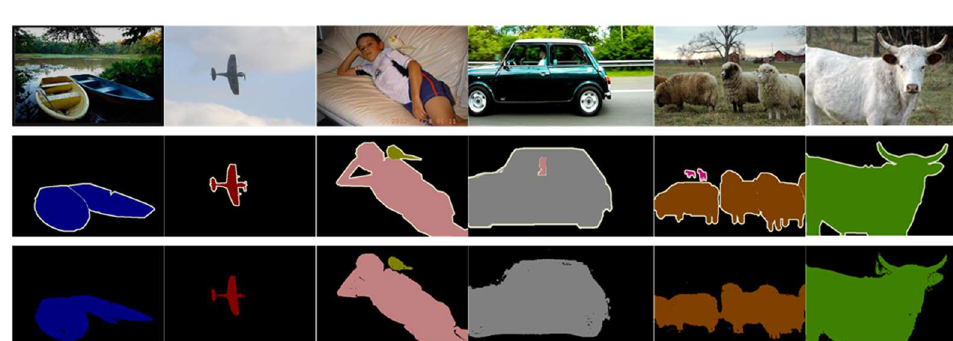
Figure 5. Pseudo masks on PASCAL VOC 2012 training dataset. Top: original images; Middle: ground truth; Bottom: prediction results.